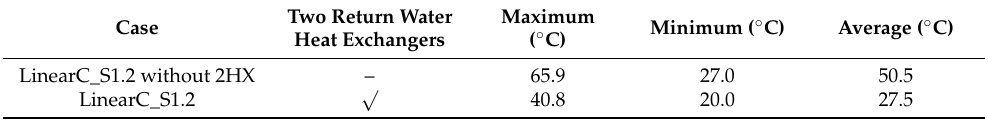
Table 4. Return water temperatures with and without two return water heat